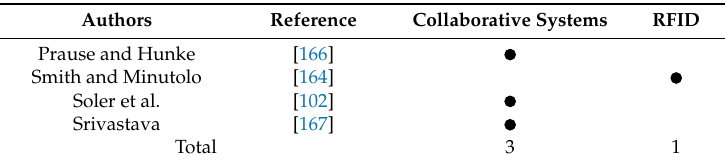
Table 4. Papers focusing on ICTs supporting energy efficiency and environmental sustainability